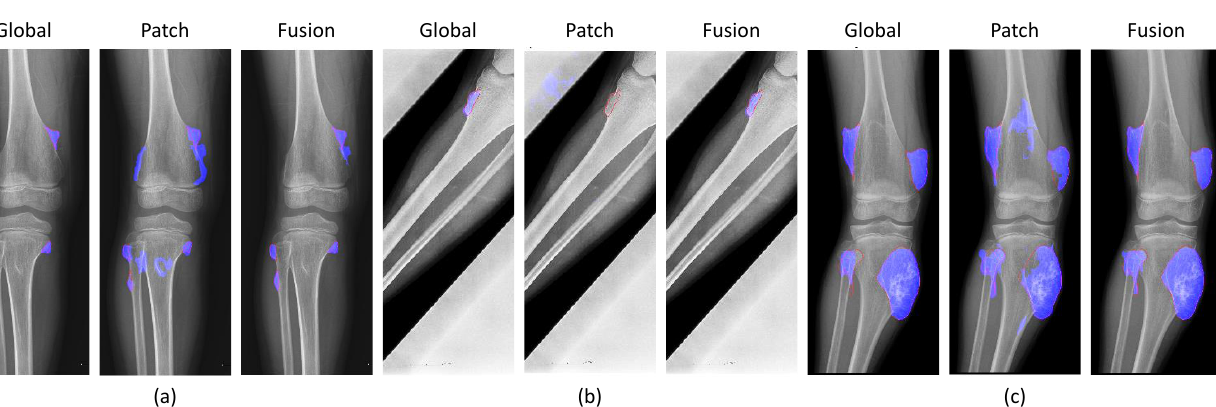
Figure 11. Successful cases of the global-based model enhancing the fusion results with ( a ) small tumors, ( b ) variant poses, and ( c ) large tumors. (red line: ground-truth, blue region: tumor detection).